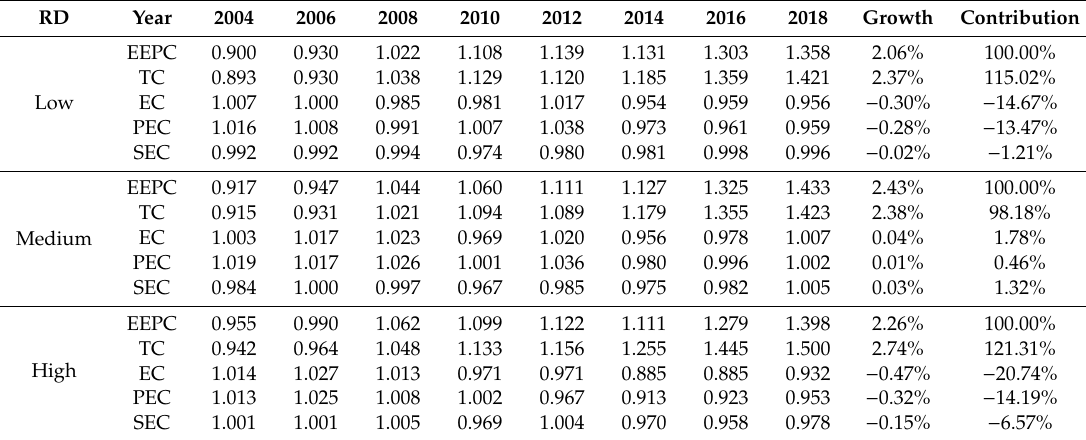
Table 4. Cumulative value of EEPC and its decomposition for classification by resource-dependence.